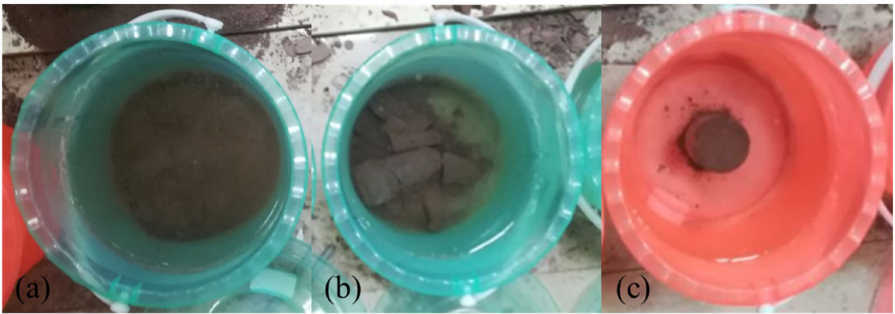
Figure 11. The 28-day specimens immersed in water: ( a ) red mud specimens; ( b ) specimens with lime; ( c ) specimens with